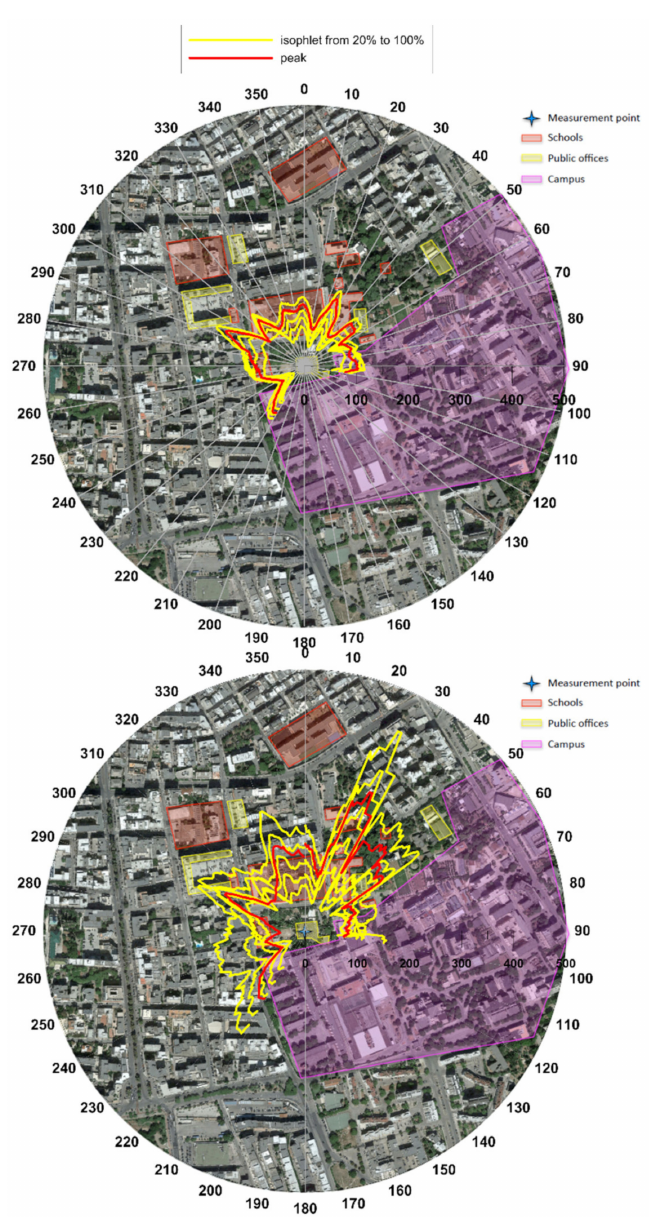
Figure 7. Maps of the sources area in unstable (upper panel) and neutral (lower panel) atmospheric conditions: The yellow lines are the footprint extensions (isopleths representing the different per- centages: 20%, 40%, 60%, 80%, 100% of the flux footprint), while the red line represents the footprint peak, all for each 10 ◦